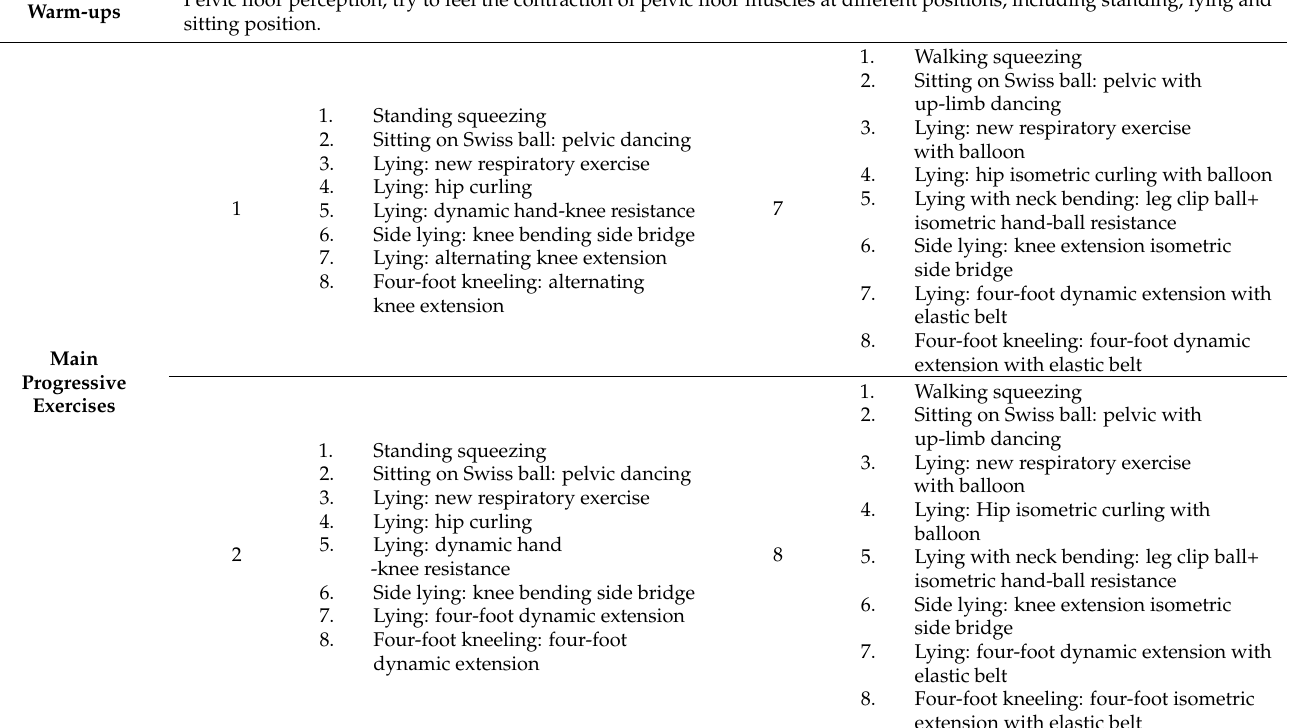
Table 1. The 12-week Pelvic Floor Workout and the sectioning. Week 8-Scetion Program Week 8-Scetion Program Pelvic floor perception, try to feel the contraction of pelvic floor muscles at different positions, including standing, lying and Warm-ups sitting position.